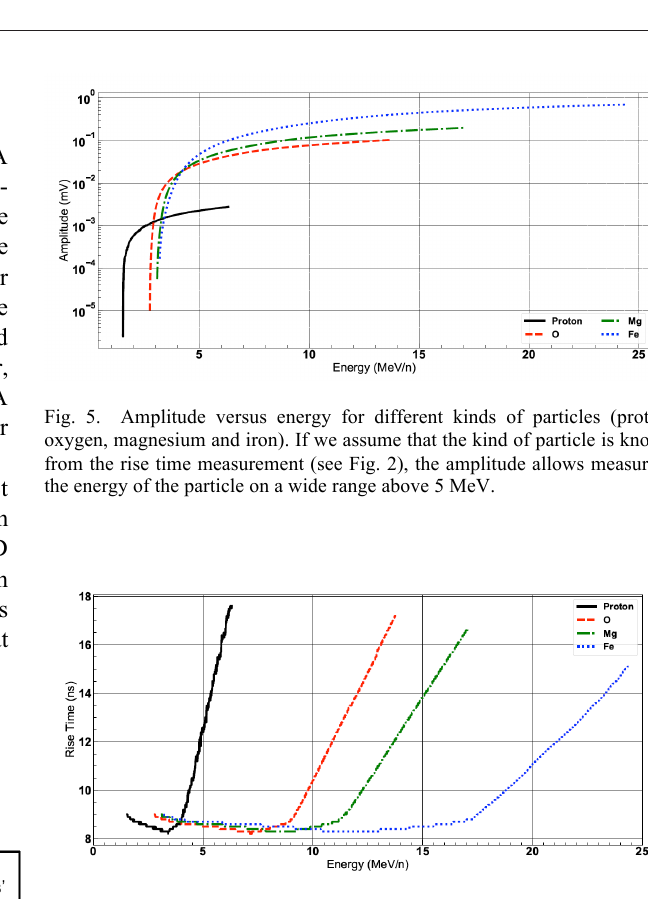
Fig. 6. Rise time versus energy for different kinds of particles (proton, oxygen, magnesium and iron). We see that the type of particle can be easily identified over a wide domain in energy by measuring the rise time of the